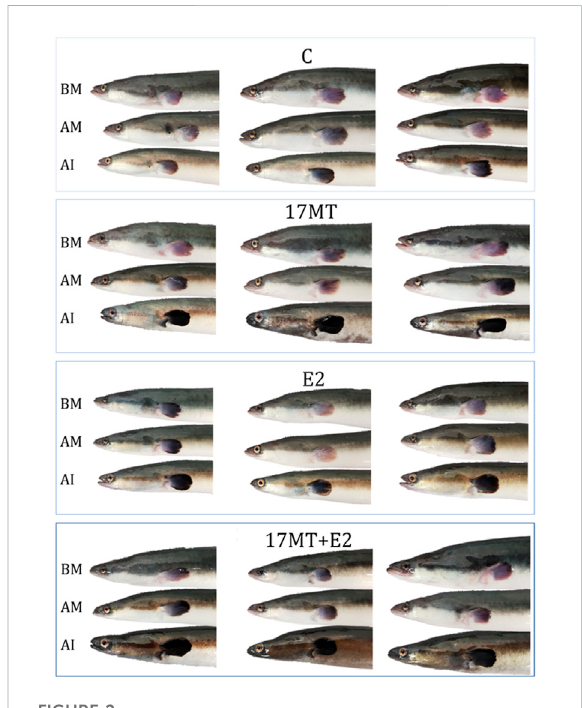
FIGURE 2 Examples of portraits of the same eels ( N = 3 representative eels per group) before migration (BM), after migration (AM) and after 8-weeks implant-treatment (AI). Eels were subjected to simulated migration to induce silvering: constant swimming in the dark at daily alternating temperatures between 10 and 15 ° C, for 83 days and covering 3,500 km. After migration, eels were equally divided over four implant treatment groups. The controls received a sham implant; the E2 group an implant with 17 β - estradiol; the 17 MT group an implant with 17 α - methyltestosterone;andthe17 MT+E2groupreceivedanimplant with 17 MT and E2. Changes in external appearance such as eye enlargement and pectoral fi n darkening were observed after migration and more advanced after implant